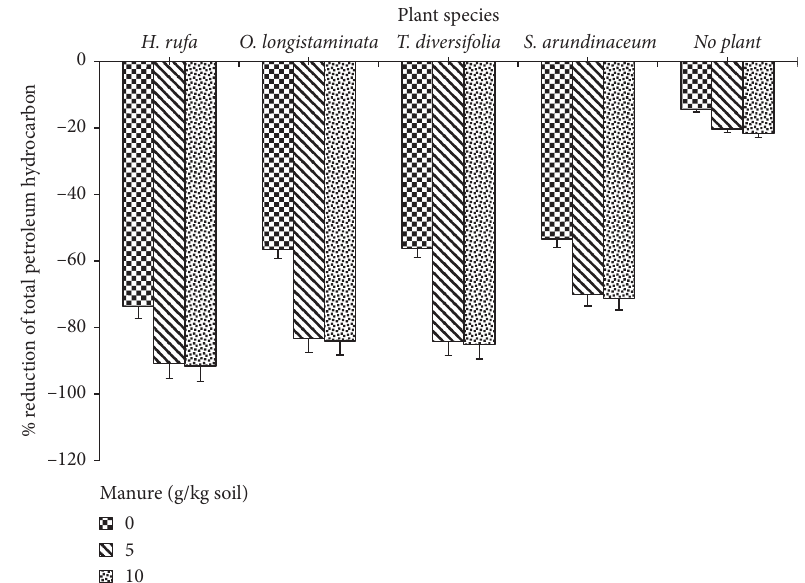
Figure 1: Effect of manure application on phytoremediation of hydrocarbon-contaminated soil; bars show the standard errors (SE) for mean percentage reduction of TPH, n �